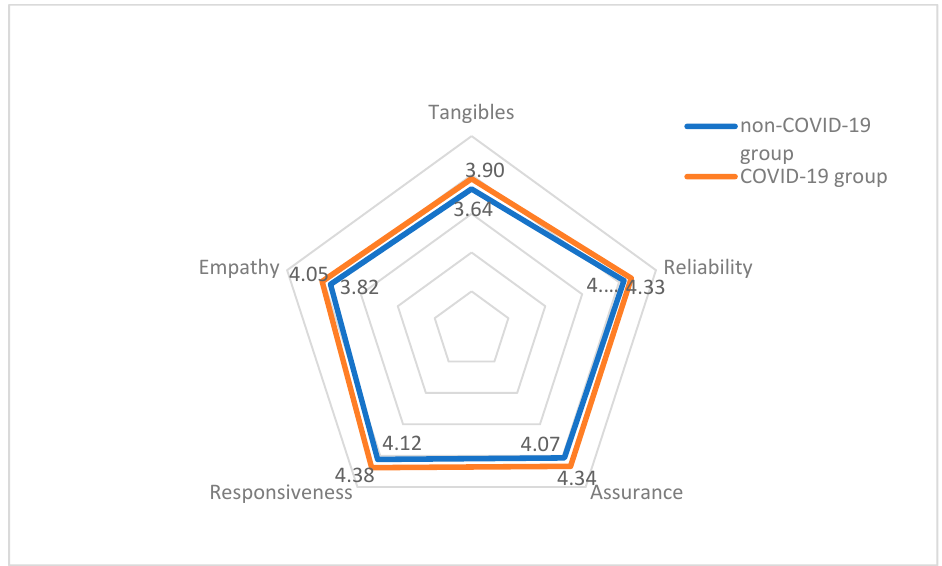
Figure 2. Comparison of all five dimensions between the COVID-19 and non-COVID-19 group.